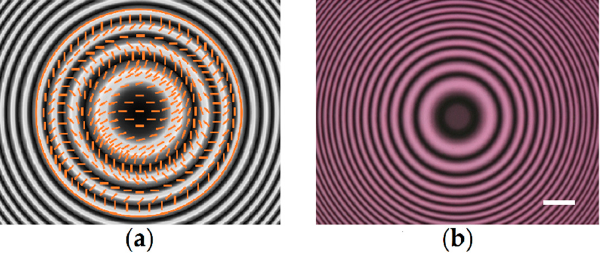
Figure 2. ( a ) Schematic director distributions and ( b ) the corresponding micrograph of the DFLC PB lens with F = 10 cm. The scale bar is 200 μ m.